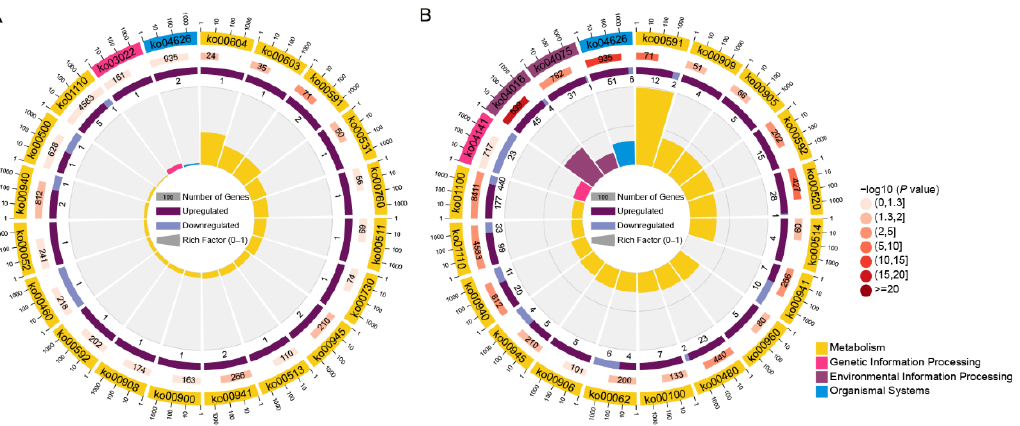
Figure 4. The top 20 KEGG enrichment results of DEGs in the addition line II-9-3: ( A ) KEGG enrichment of A. cristatum DEGs; ( B ) KEGG enrichment of wheat DEGs.